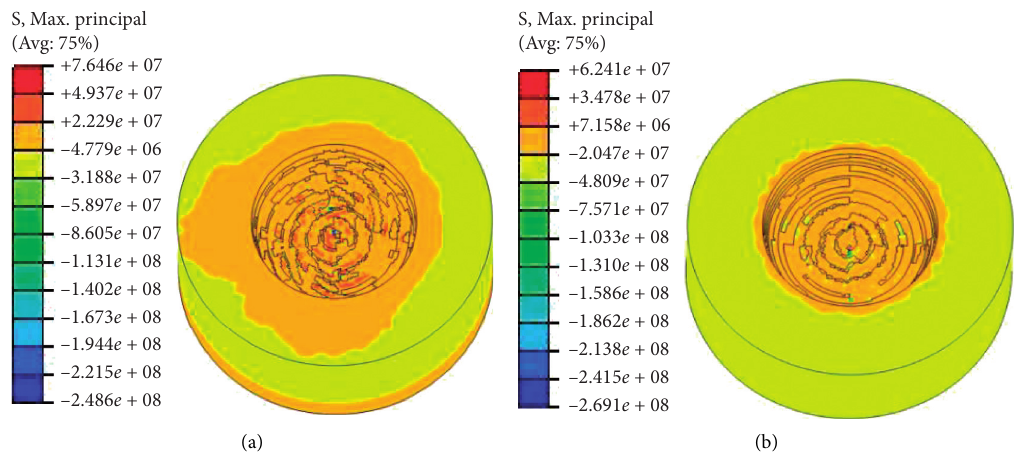
Figure 12: Maximum principal stress of rock by different bit. (a) Cross-cutting PDC bit. (b) Conventional PDC